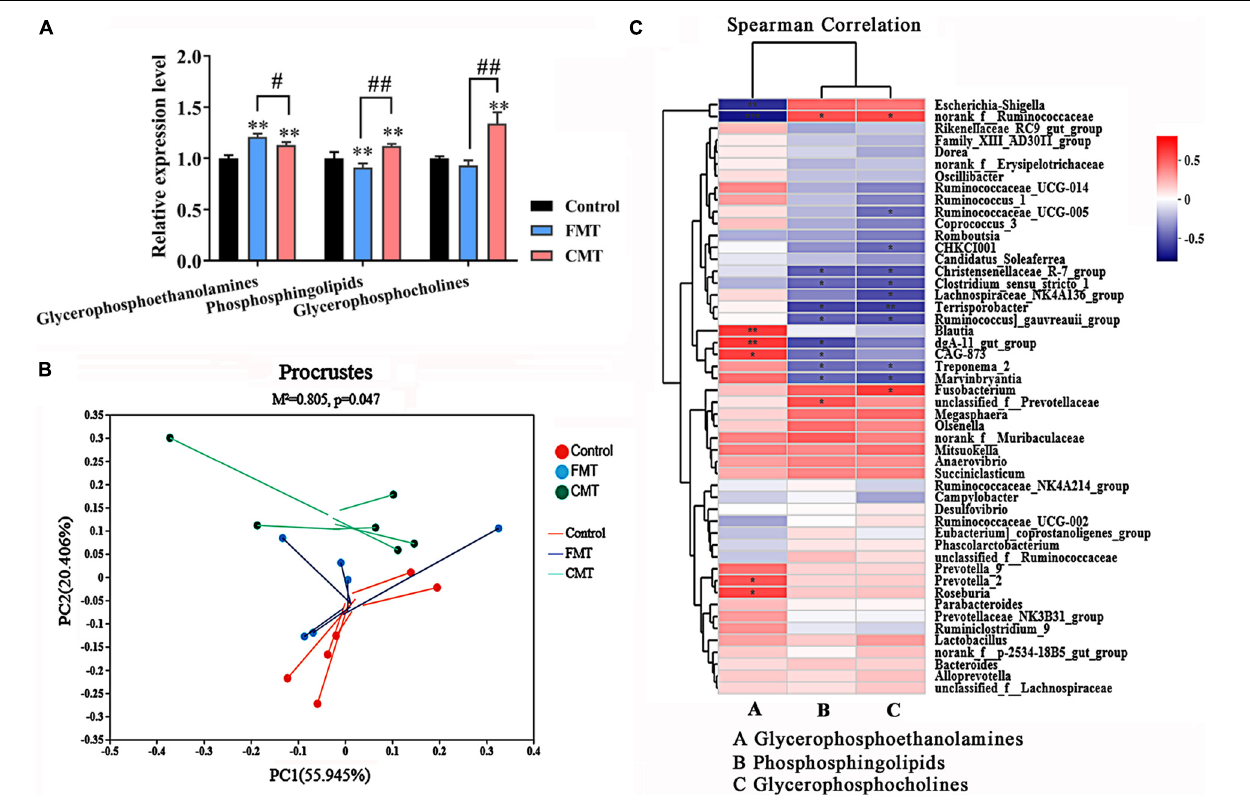
FIGURE 9 | Corrections between intestinal microbiota and lipids metabolism. (A) Composition of the three major altered lipid species in the different piglets ( n = 6); ** indicates P < 0.01 with the control, ## indicates P < 0.01 and # indicates P < 0.05 between the FMT and CMT groups. (B) Procrustes analysis shows a significant correlation between lipid profiles and the microbial community. (C) Heatmap of Spearman’s correlation coefficients between the intestinal microbiota and the three major altered lipid species. The colors range from blue (negative correlations) to red (positive correlations). Significant correlations are noted by ** P < 0.01 and * P <